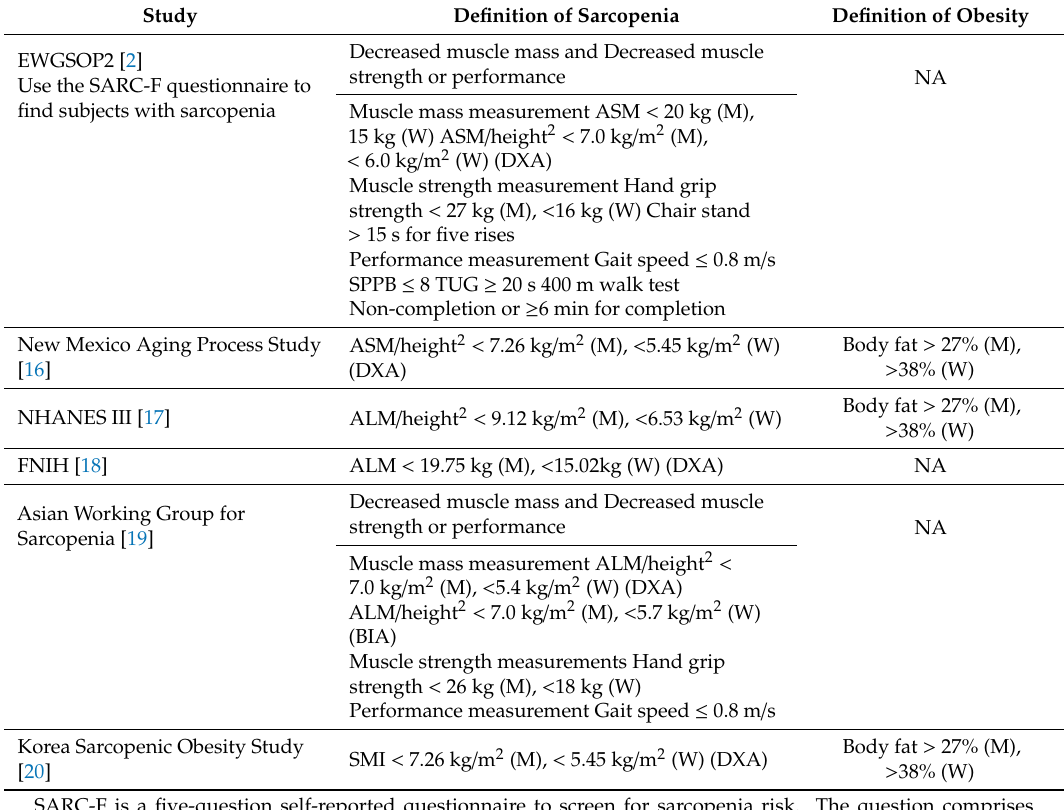
Table 1. Diagnostic criteria for sarcopenic